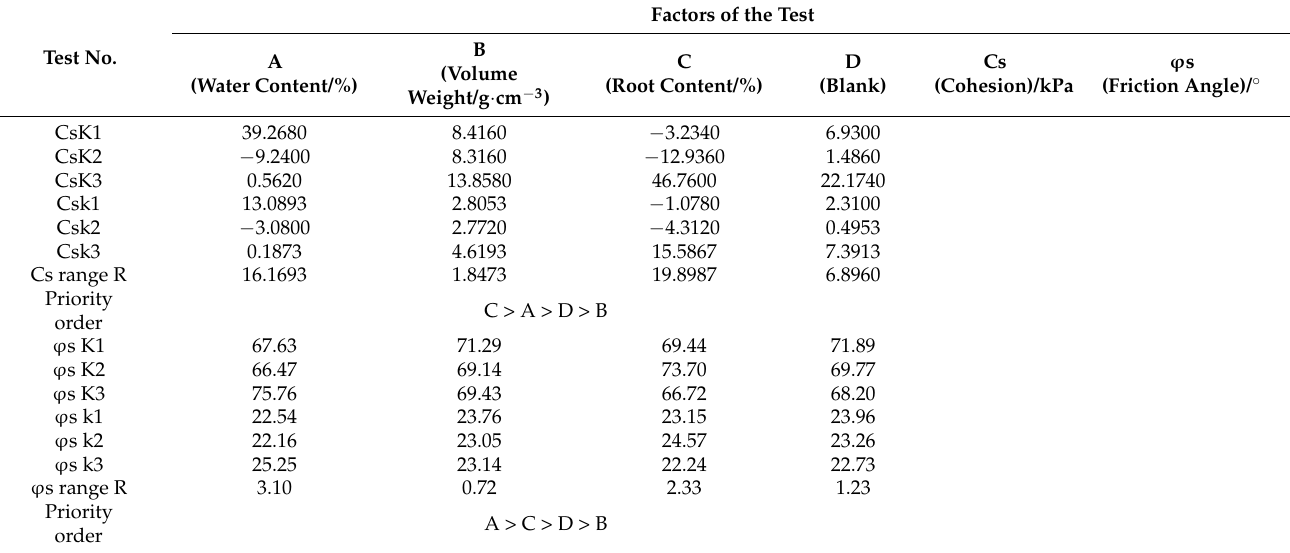
Table 5. Range analysis table of shear strength of the root–soil